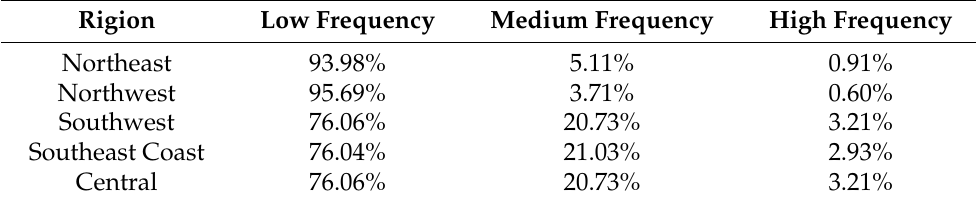
Table 3. Trip frequency statistics. Northwest China and Northeast China are relatively similar, with the low-frequency population reaching 90%, medium-frequency population being 5% or less, and high-frequency population being less than 1%; Southwest, Southeastern coastal areas, and central regions showed similar results, with low-frequency populations at about 76%, medium frequency populations at about 20%, and high-frequency populations at about 3%.